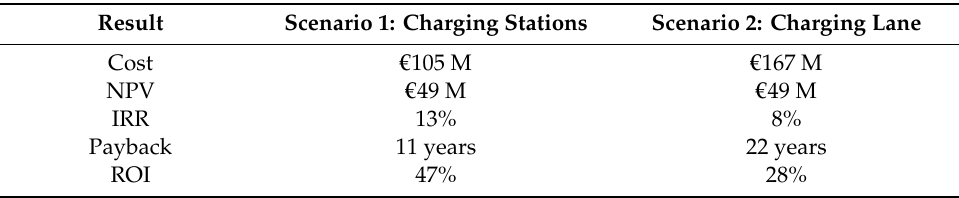
Table 2. Economic analysis of the charging